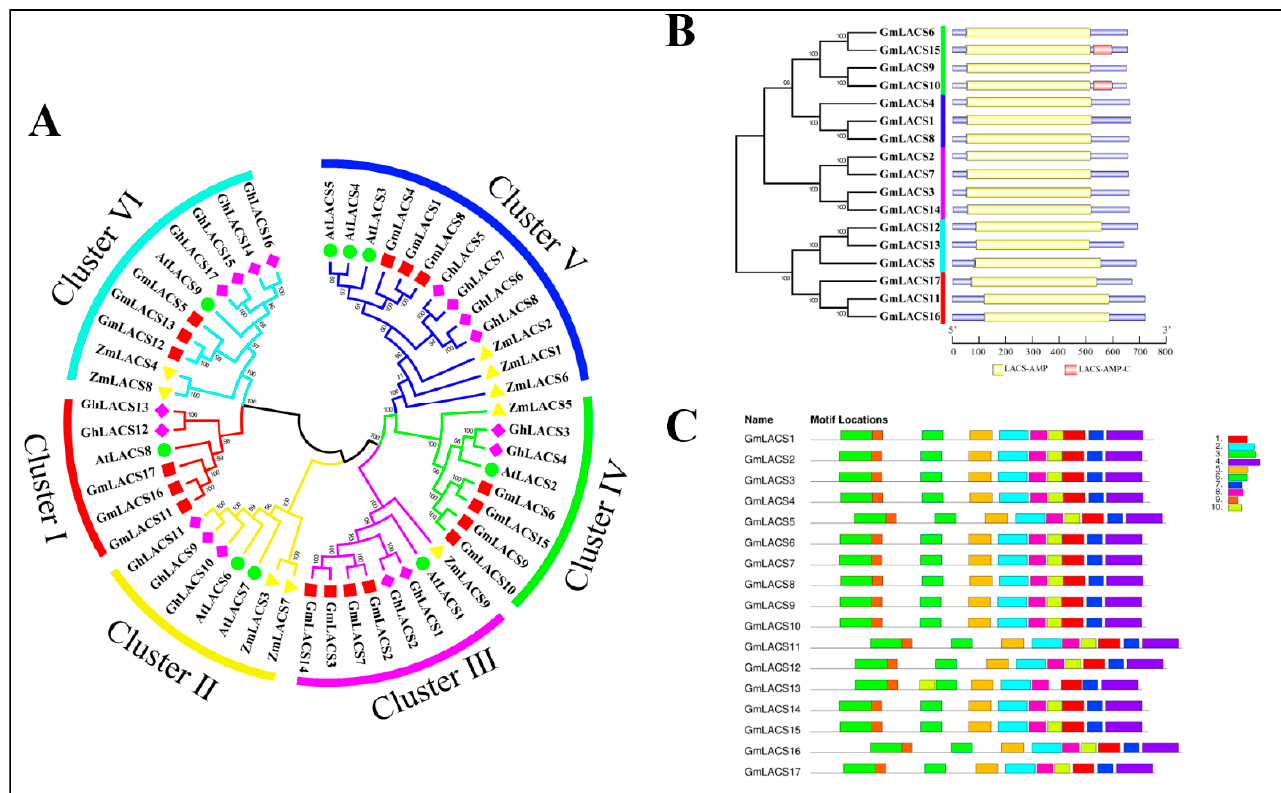
Figure 1. Phylogenetic, protein domain and protein conserved motifs analysis of GmLACSs. ( A ) Phylogenetic tree of LACS proteins from GmLACSs (red squares), AtLACSs (green circles), ZmLACSs (yellow triangles), and GhLACSs (purple diamonds). ( B ) The protein domain was se- quenced and analyzed by subfamily. The blue circle was the protein sequence length (5 ′ -3 ′ ), the yellow circle was GmLACS-AMP, and the red circle was GmLACS-AMP-C. Each protein sequence is proportional in length. ( C ) The conserved motifs were identified by MEME program. Each motif is indicated by a colored box that displays a number and gray lines represent the non-conserved sequences. The length of motifs in each protein is proportional.